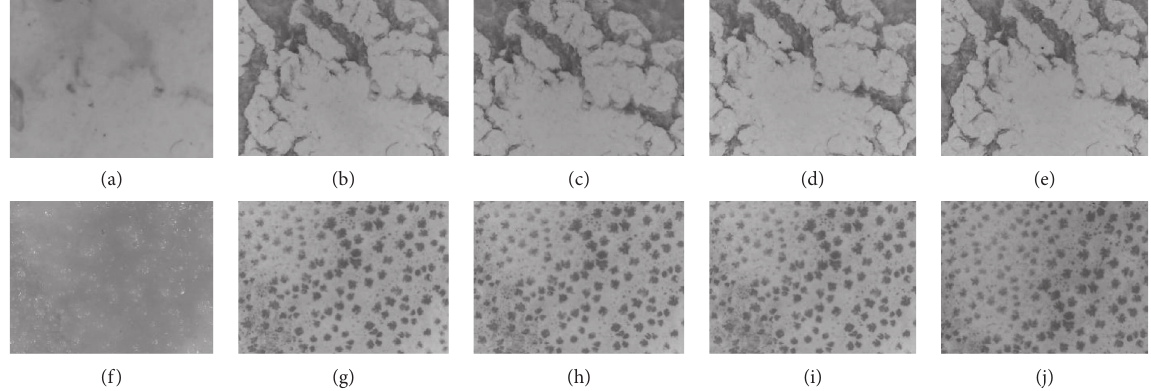
Figure 4: Microscopic images of MB and MPB. (a) MB: 0 hour. (b) MB: 1 hour. (c) MB: 12 hours. (d) MB:24 hours. (e) MB: 48 hours. (f)